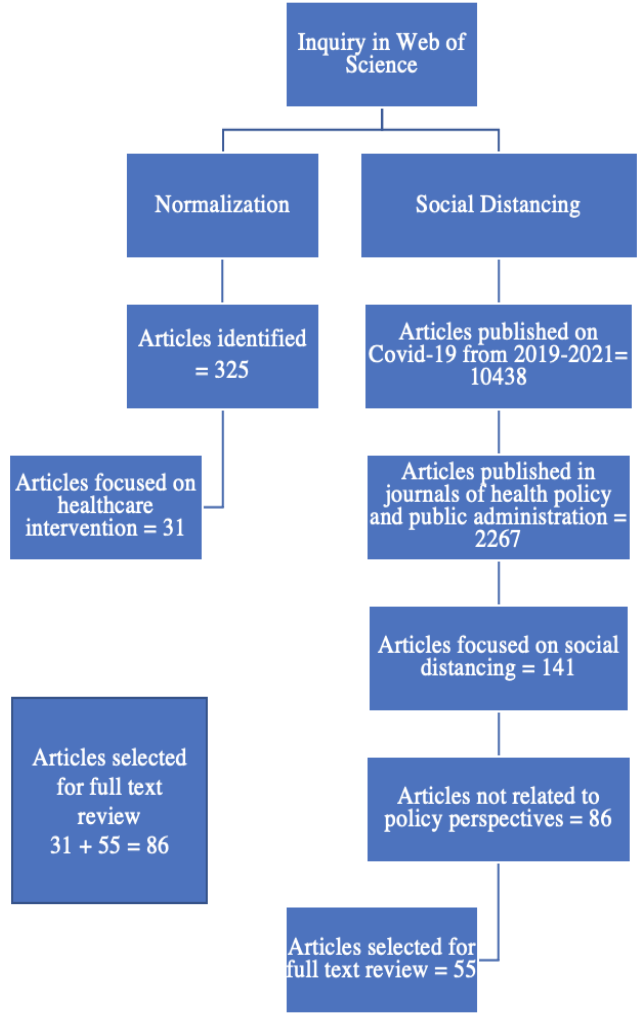
Figure 1. Search strategy of the literature.